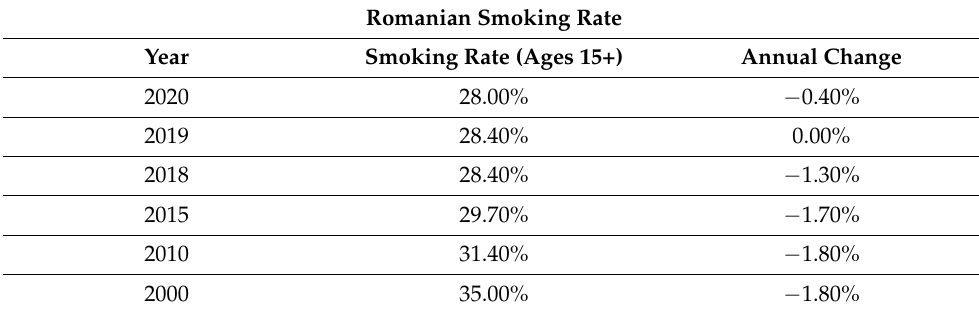
Table 1. Romanian smoking rate [9].